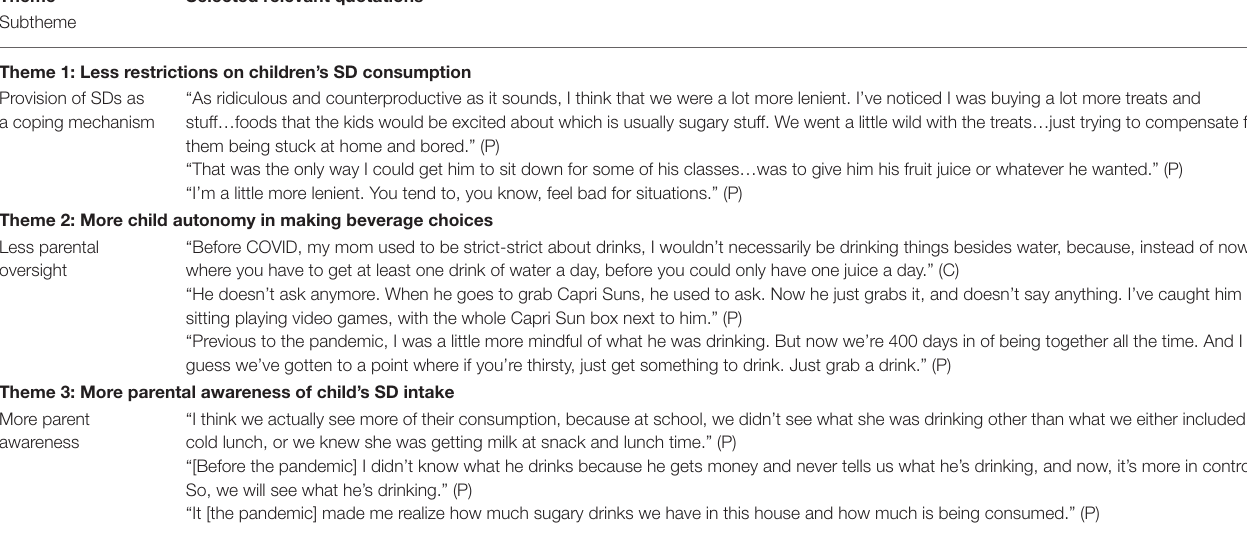
TABLE 3 | The pandemic altered parents’ oversight of children’s SD consumption. Theme Selected relevant quotations a Subtheme Theme 1: Less restrictions on children’s SD